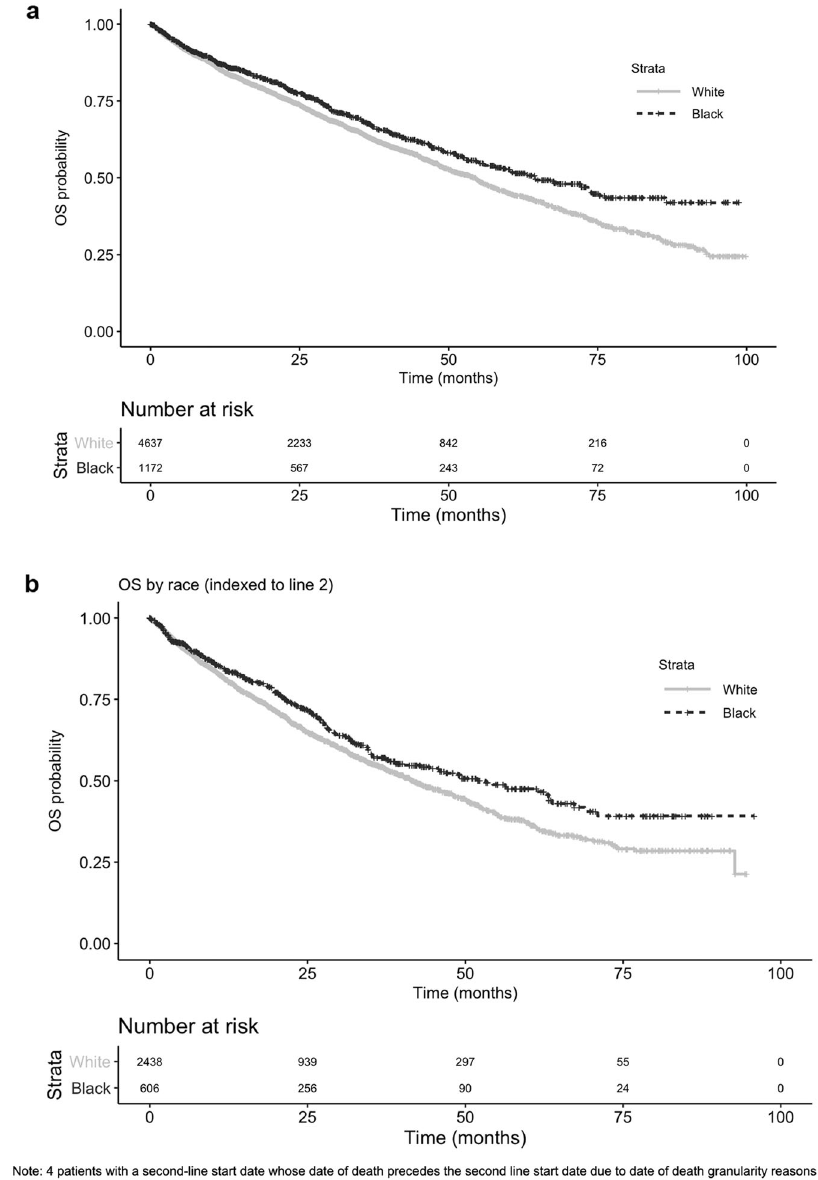
Fig. 1 Kaplan – Meier estimates of rwOS by race. a rwOS indexed to fi rst line of therapy. b rwOS indexed to second line of